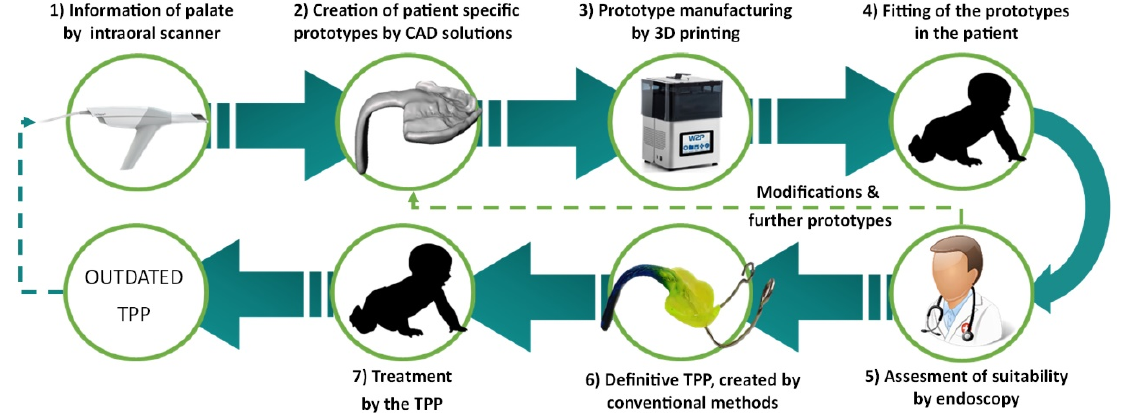
Figure 3. Current semi-digital workflow for the treatment of RS patients with the TPP.